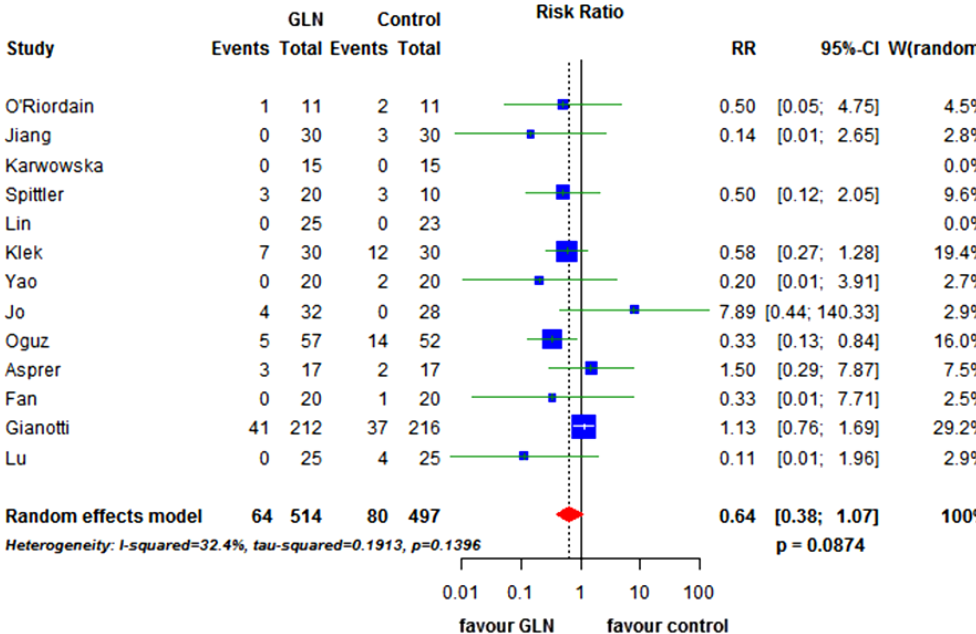
Figure 5. Forest plot for infectious morbidity comparing GLN vs. control. GLN: glutamine, RR: relative risk, CI: confidence interval.